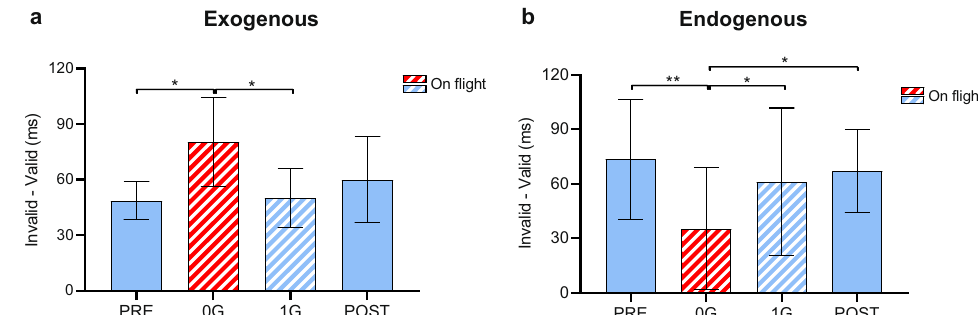
Fig. 3 Validity effect for the two tasks across conditions. Mean values and SD ( n = 5) are reported. a E xogenous task: the validity effect was larger in 0 g compared to PRE and 1 G, and there was a similar trend for POST ( P = 0.055); b endogenous task : the validity effect was smaller in 0 g compared to all 1 g conditions. Newman – Keuls post hoc analyses, * P ≤ 0.05 and ** P ≤ 0.01. PRE = 1 g before the fl ight, 0 G = 0 g on the fl ight, 1 G = 1 g on the fl ight, POST = 1 g after the fl